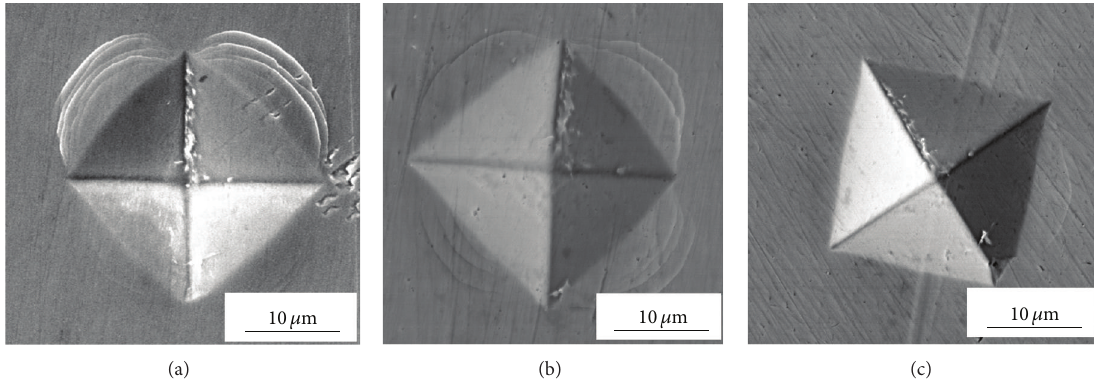
Figure 7: Morphologies of Vickers’ indentation for different positions of Zr51 alloys under loading 500g: (a) with multiple shear bands for outer location #1, (b) with a small quantity of shear bands for middle location #2 and (c) without shear bands for center location